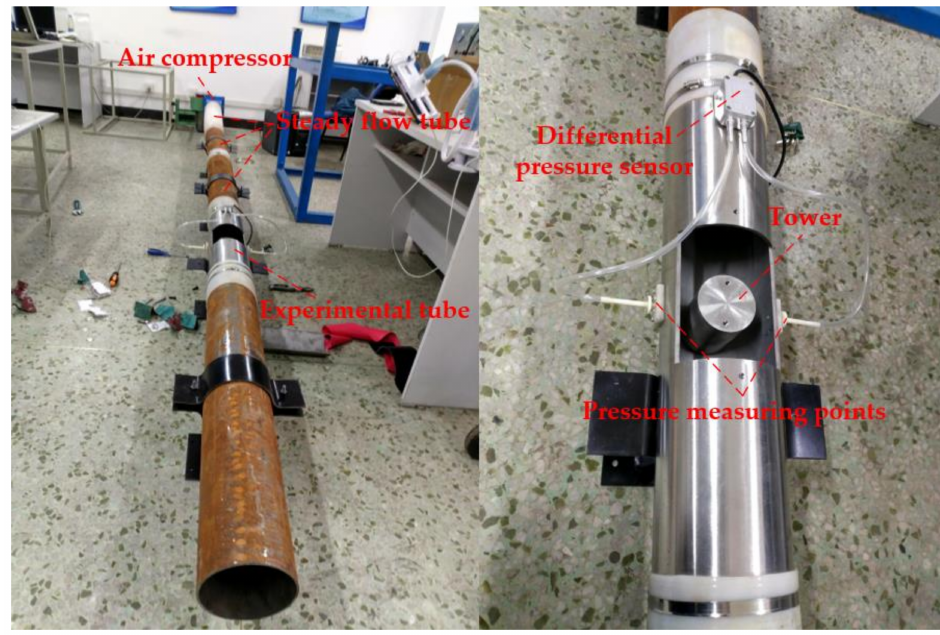
Figure 17. Structure and components of the wind-tunnel test rig.